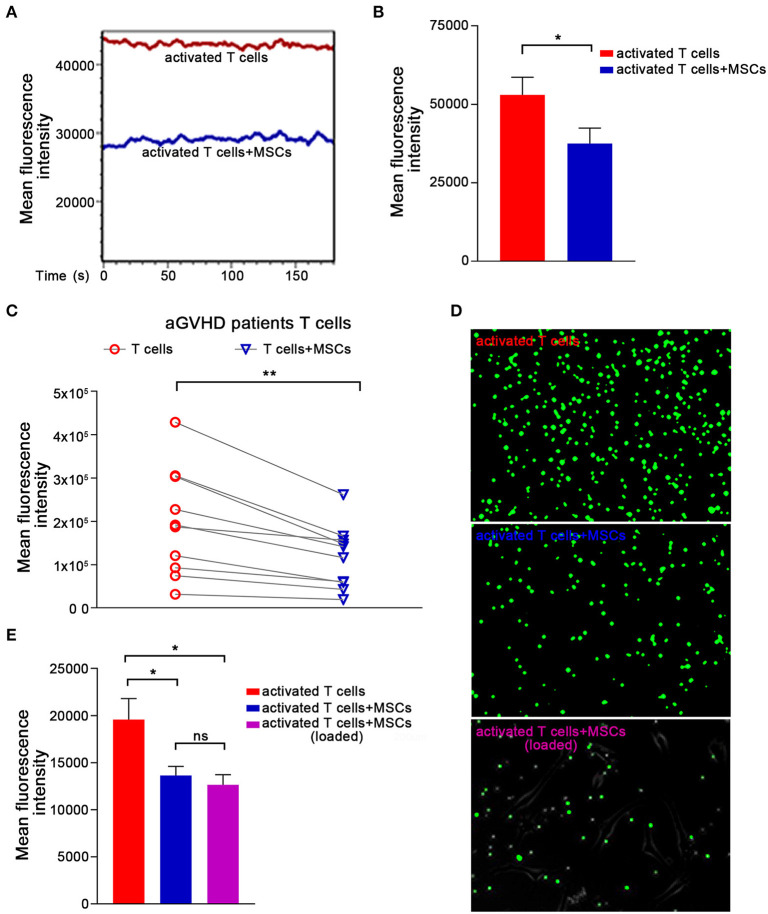
The Ca2+ signaling in activated T cells are rapidly abrogated by MSCs. (A) T cells were stimulated with CD3mAb and CD28mAb for 1 h, labeled with the Ca2+-sensitive dye Fluo-4 AM, and then cocultured with MSCs for 1 h. Activated T cells were analyzed via flow cytometry to monitor dynamic changes in cytosolic Ca2+ levels. Data are representative of 10 donors. (B) Column chart shows the mean fluorescence intensity (MFI) of the activated T cells described in (A). Data are presented as the means ± SEM from 10 donors. (C) T cells from patients were labeled and cocultured as described in (A) and assessed by flow cytometry. The data represented were from 10 patients. (D) Plates were pre-coated with poly-lysine, loaded (or not) with MSCs, and Ca2+ indicator-loaded activated T cells were added and allowed to adhere. T cells (top), T cells removed from the coculture (middle), or those that adhered to the plated MSCs (lowest) are shown. Representative photos were taken by under a live-cell microscope. (E) Column displaying the mean fluorescence intensity (MFI) of the activated T cells and MSCs-cocultured activated T cells described in (D). Data are presented as the means ± SEM from three donors. Significant differences are indicated as follows: ns, no statistical significance; *p < 0.05, and **p < 0.01.